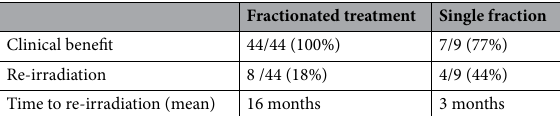
Table 2. Single versus fractionated protocol outcome.